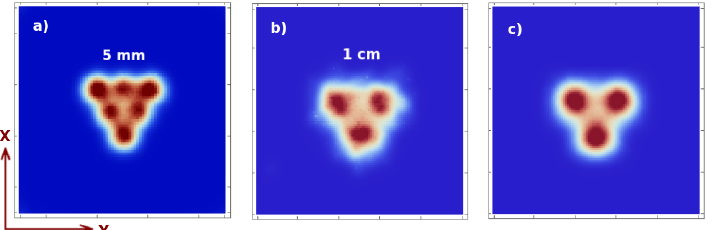
Figure 5. Image reconstruction of 5 mm Derenzo-like spherical phantom (with 0.1 MBq activity of each sphere) at z = 4 cm (see reference system defined in Figure 2) and 1 min acquisition time ( a ); 1 cm Derenzo at z = 10 cm with 1 min acquisition time ( b ); and 5 min acquisition time ( c